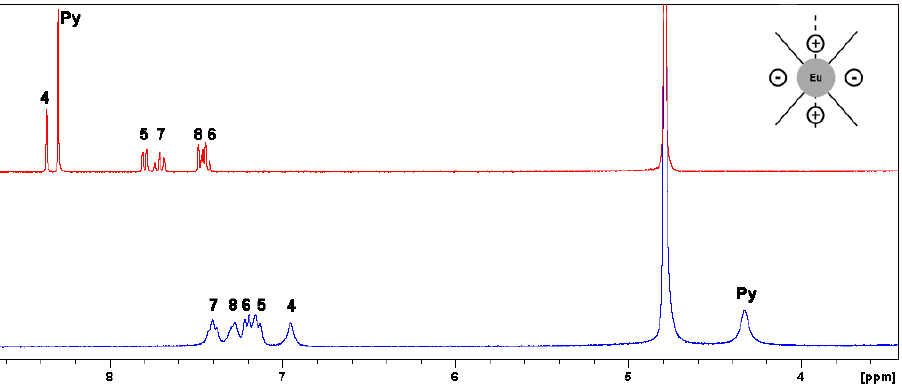
Figure 1. 1 H-NMR (400 MHz, D 2 O) spectra of L 1 (triethylammonium salt, red) and Na 3 [Eu(L 1 ) 3 ] (blue) with sign guide diagram (for nuclei numbering refer to Scheme